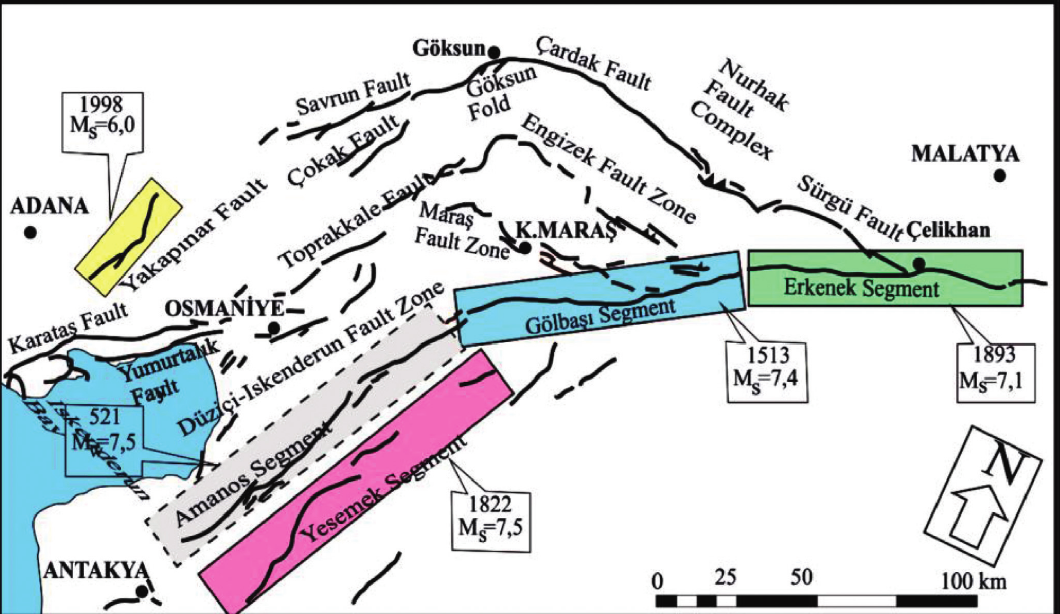
Figure 2: Surface ruptures along the EAFZ [18].